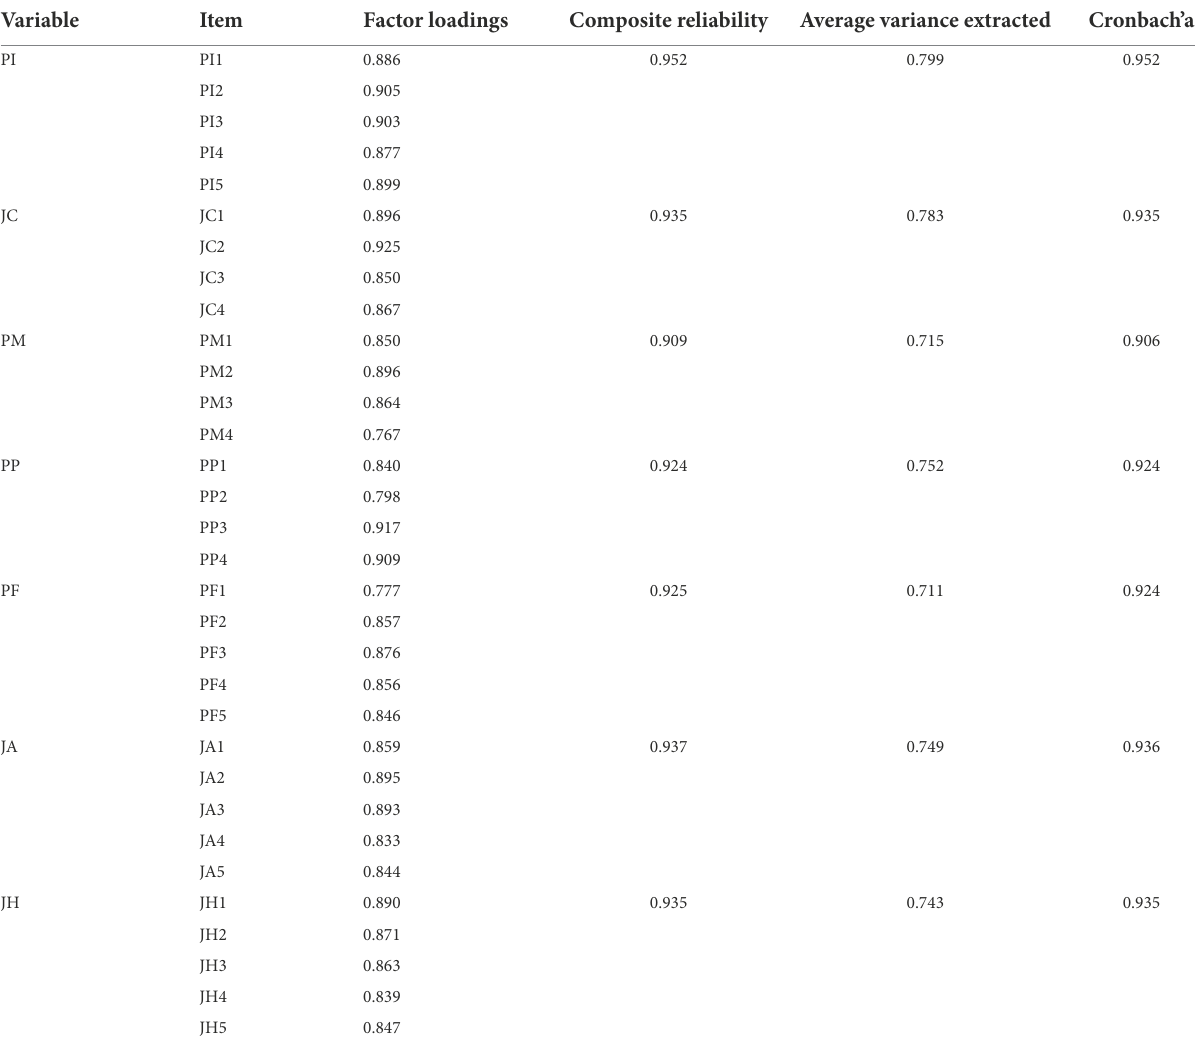
TABLE 2 Confirmatory factor analysis.